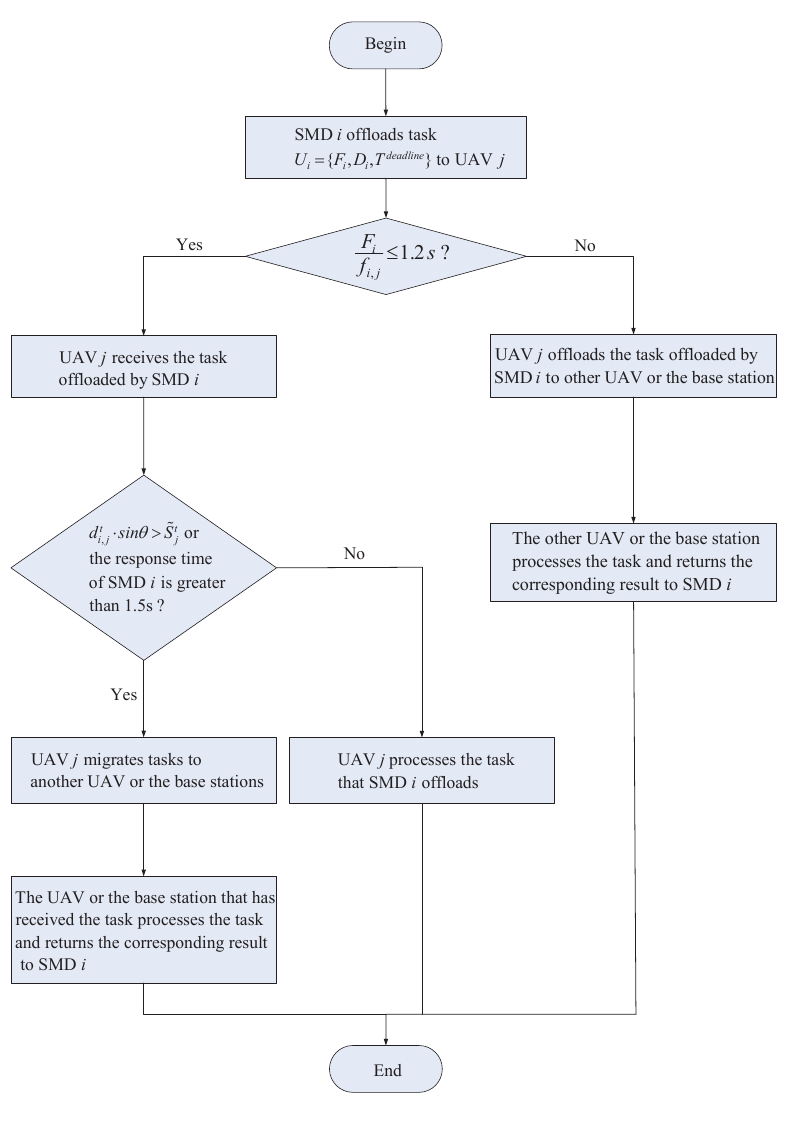
Figure 3. Service range of UAV j